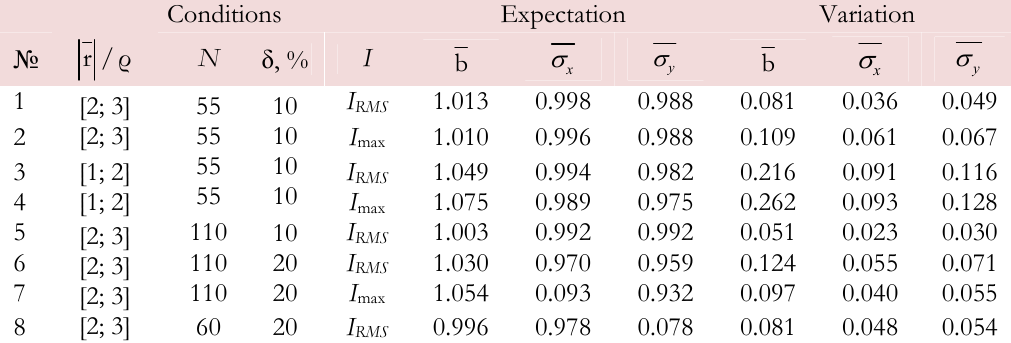
Table 1: The influence of the experimental error on the values of the unknown parameters (numerical